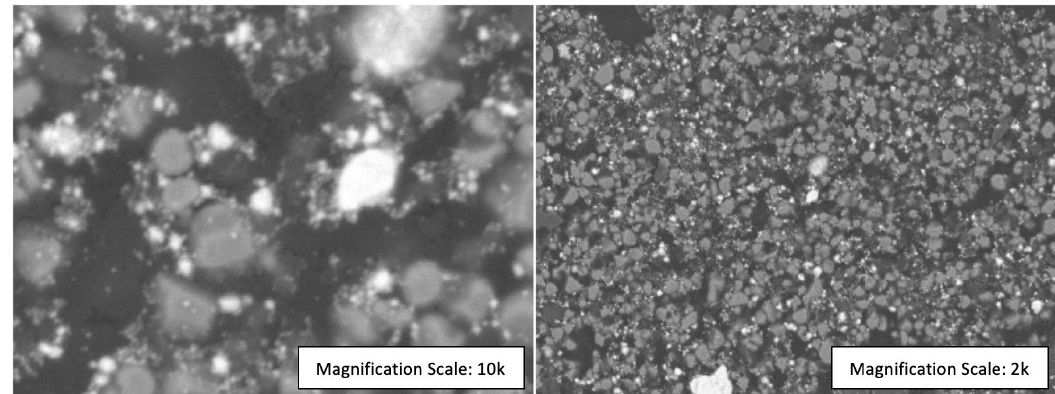
Figure 10. Micrograph of sample of 25% aluminum oxide – 75% CRFO powder, with magnification of (a) 10,000x and (b) 2000x.